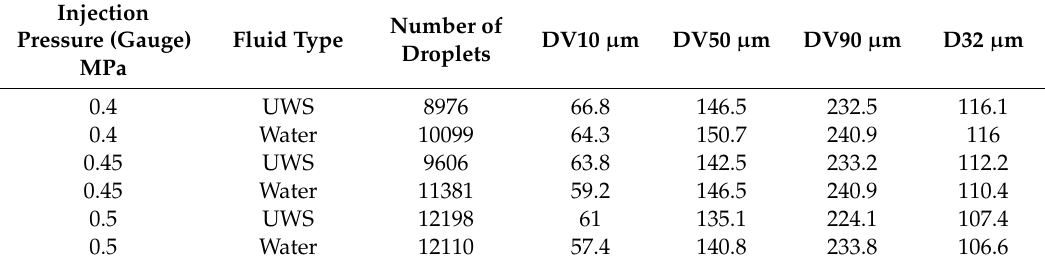
Table 4. Droplet cumulated statistics (for 99